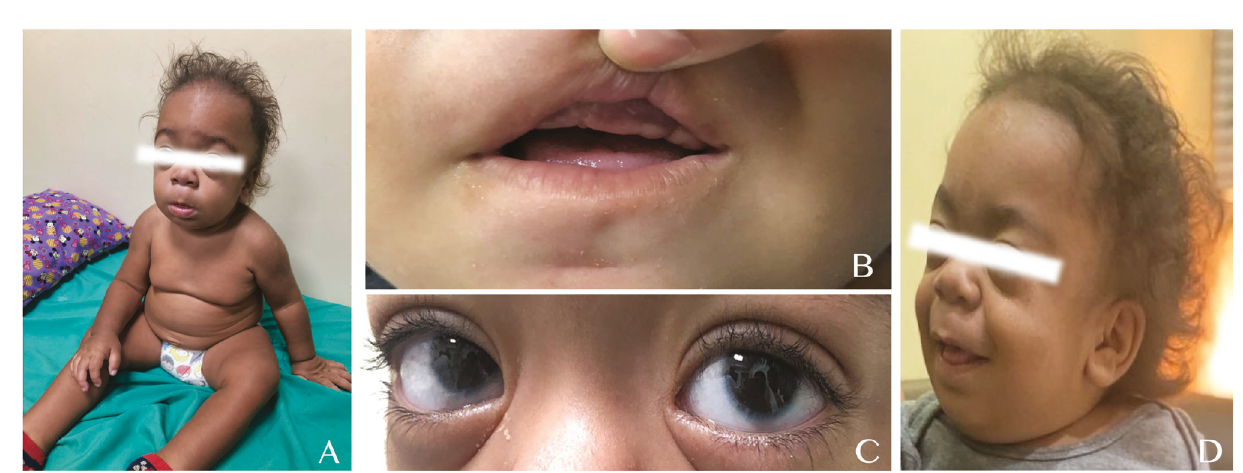
Figure 1. Clinical features of Hurler Syndrome. (A) Coarse face. Enlarged forehead, depressed and broad nasal bridge, ocular hypertelorism,